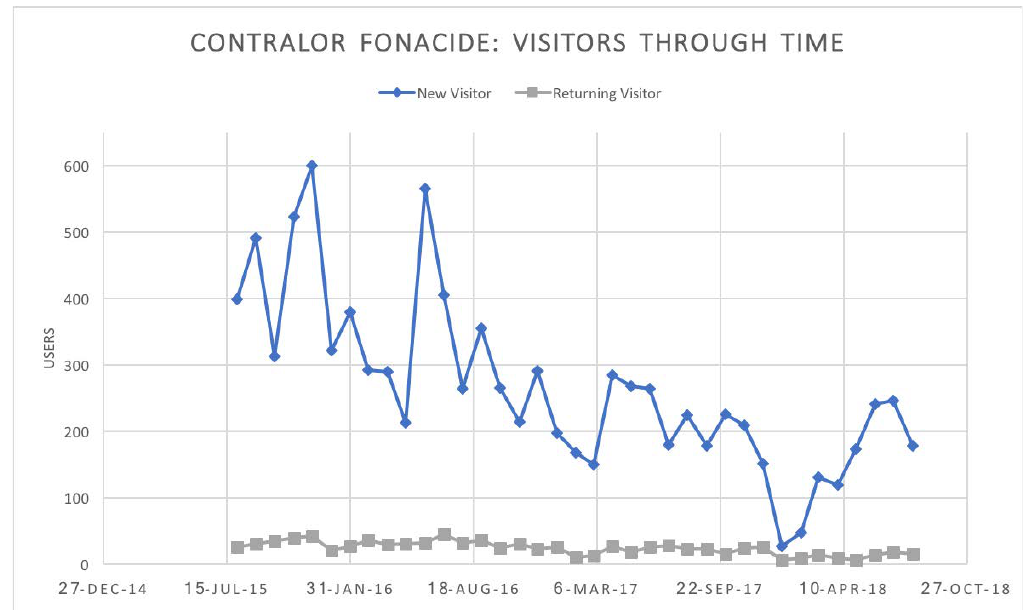
Figure 5: Contralor FONACIDE: Visitors through Time